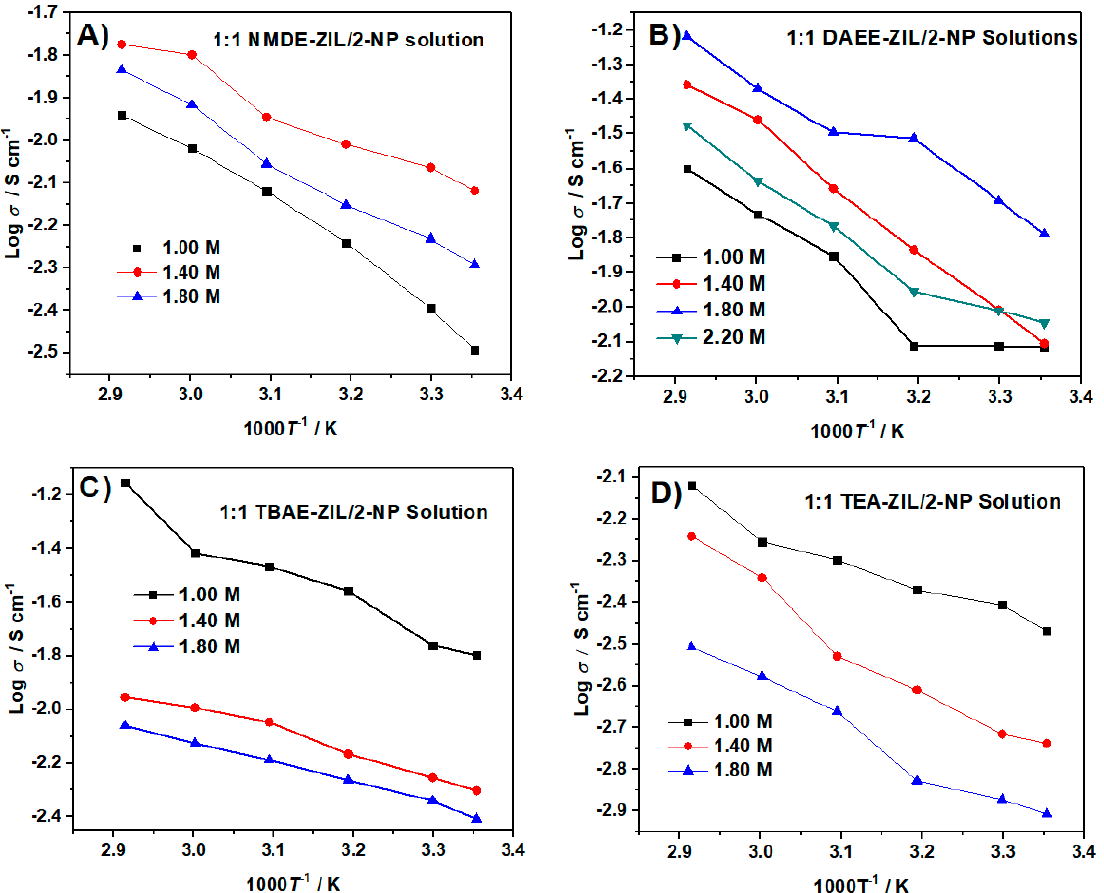
Figure 11. Temperature dependence of ionic conductivities of different LiTFSI concentrations of 1:1 weight ratio of ( A ) NMDE-ZIL, ( B ) DAEE-ZIL, ( C ) TBAE-ZIL, ( D ) TEA-ZIL and 2-NP solutions at the temperature range between 25 and 70 °C. Table 9. The optimum ionic conductivity of 1:1 weight ratio of ZIL/2-NP mixtures containing optimum LiTFSI concentration.